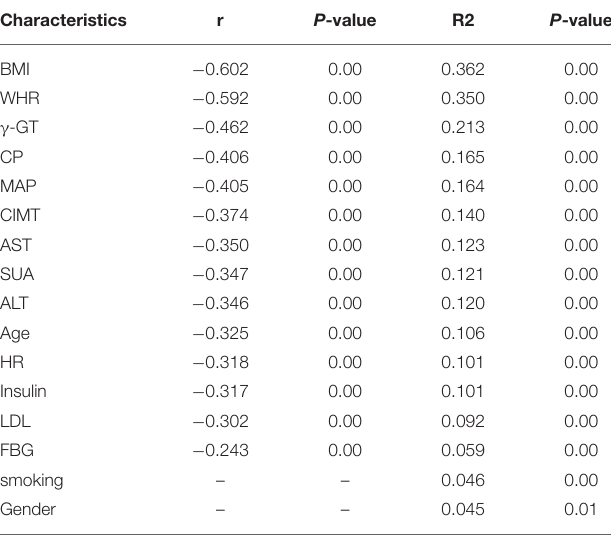
TABLE 3 | The correlation and univariate analysis of FMD and 16 variables. Characteristics